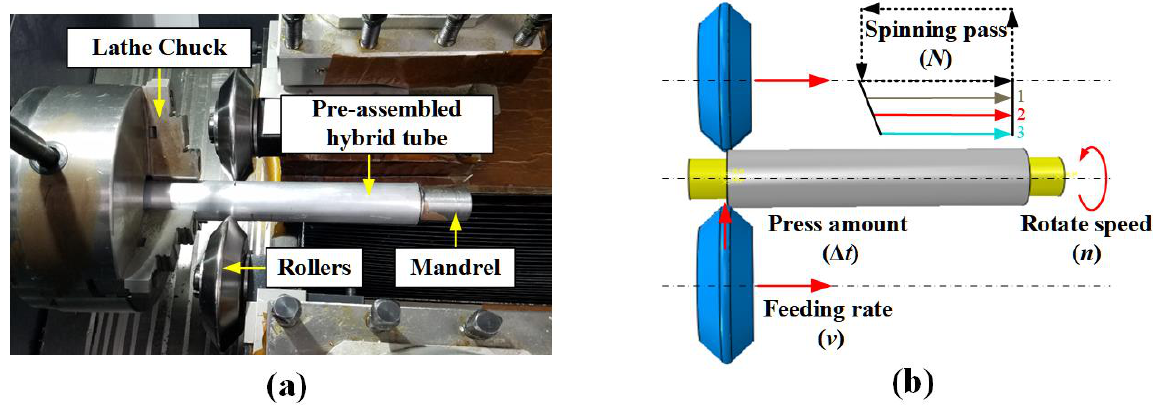
Figure 2. Power spinning process: ( a ) experimental set-up; ( b ) diagram of forming parameters.